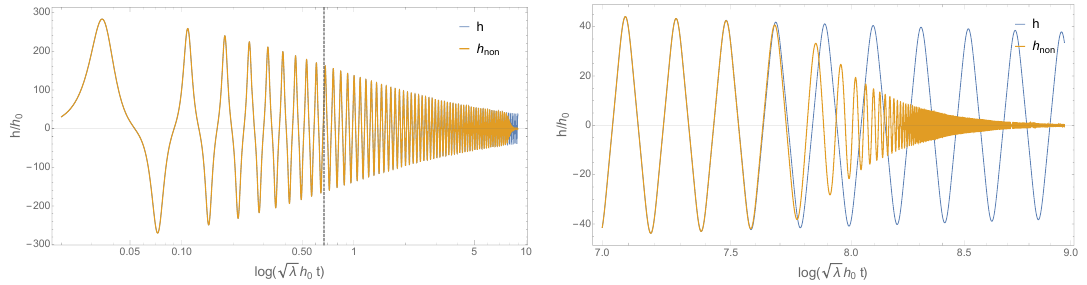
Figure 14 . The evolution of Higgs mode functions with (cid:3) I = 5 (cid:2) 10 15 GeV and (cid:3) = 2 (cid:2) 10 16 GeV. The blue (orange) line shows the evolution without (with) non-pertubative decay. The dashed line is the time when maximum temperature is